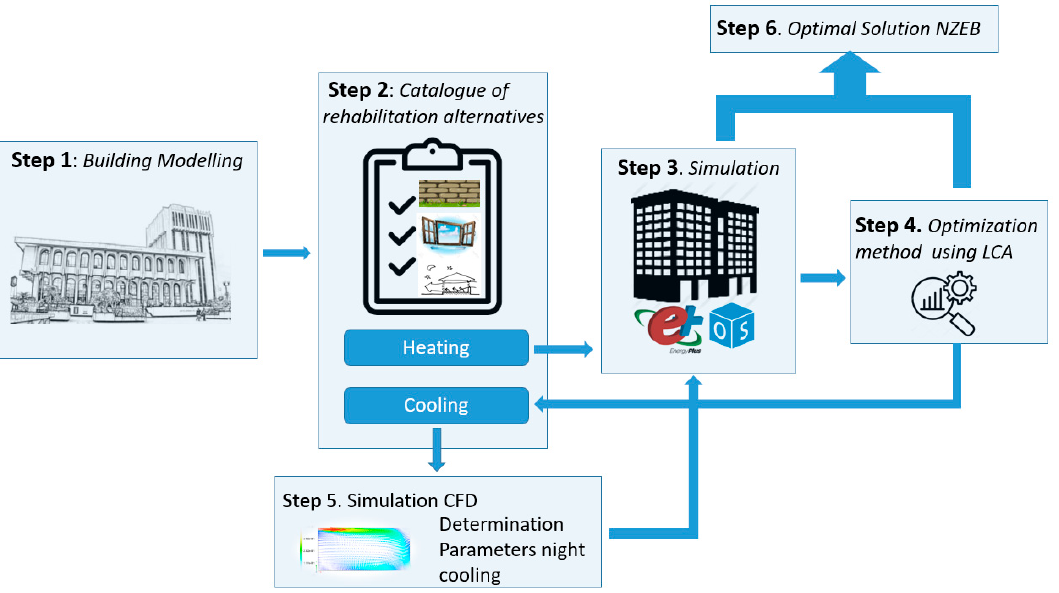
Figure 1. Overview of the methodology. CFD: Computational Fluid Dynamics; NZEB: Near Zero Energy; LCA: Life cycle assessment